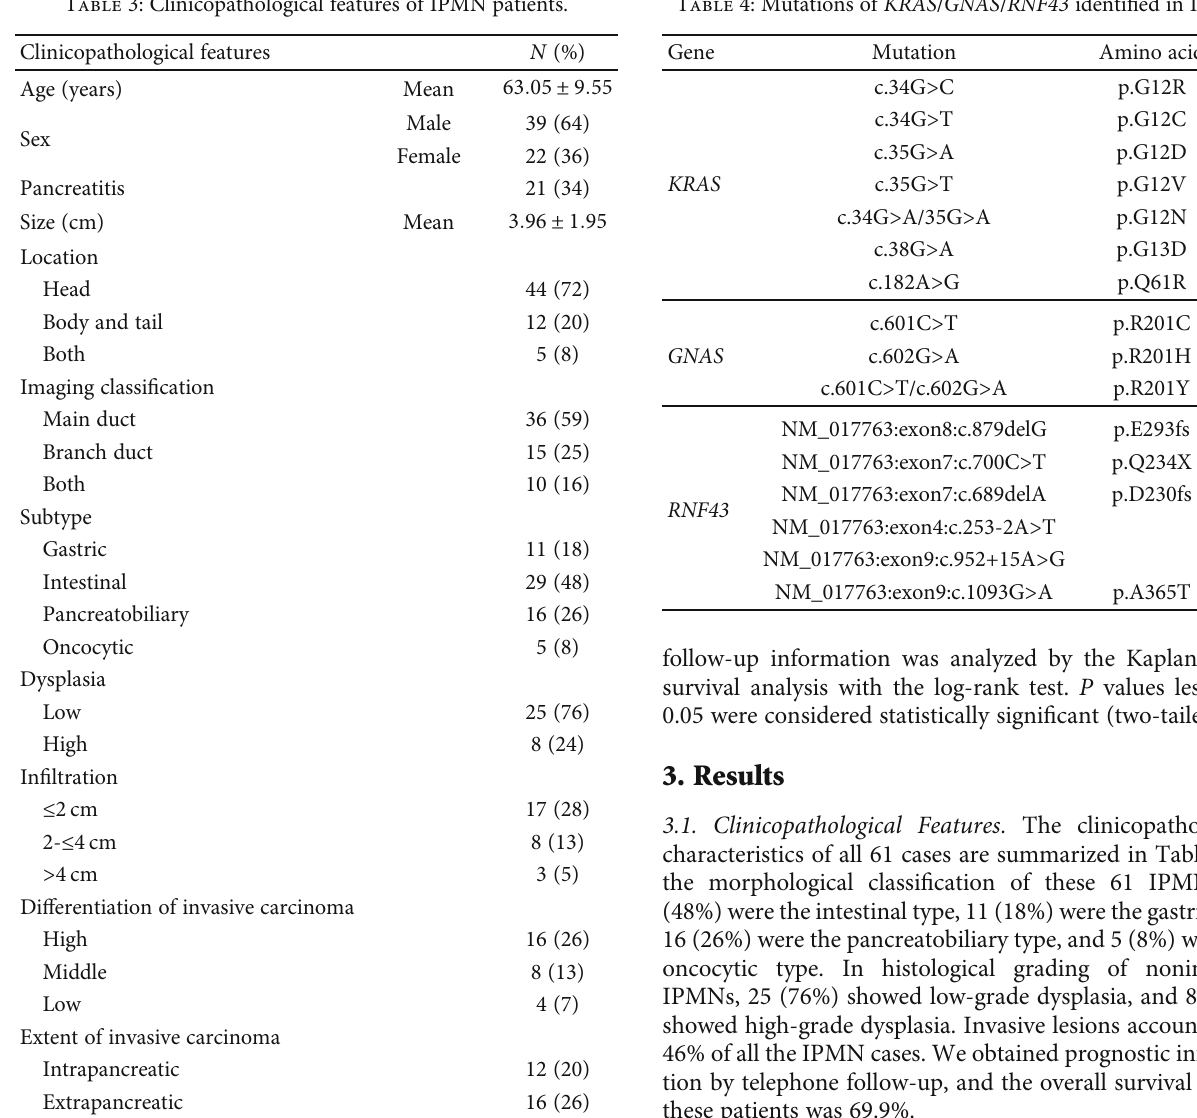
Table 4: Mutations of KRAS / GNAS/RNF43 identi fi ed in IPMN.